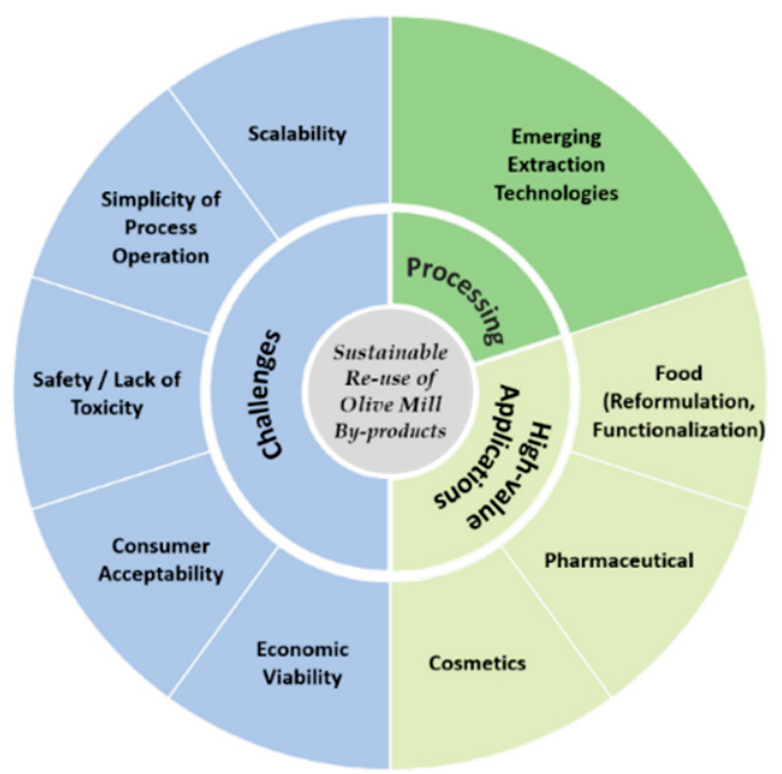
Figure 2. Summary of the associated factors accountable for the sustainable valorization of olive mill by-products.